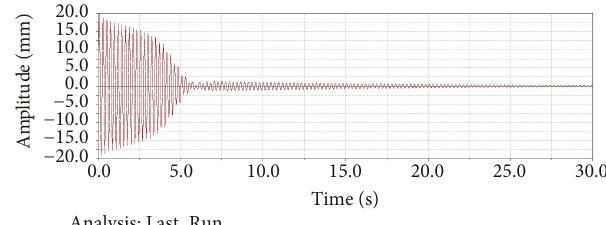
Figure 10: Vibration response of the flexible arm subjected to the damping of the vibration absorber.